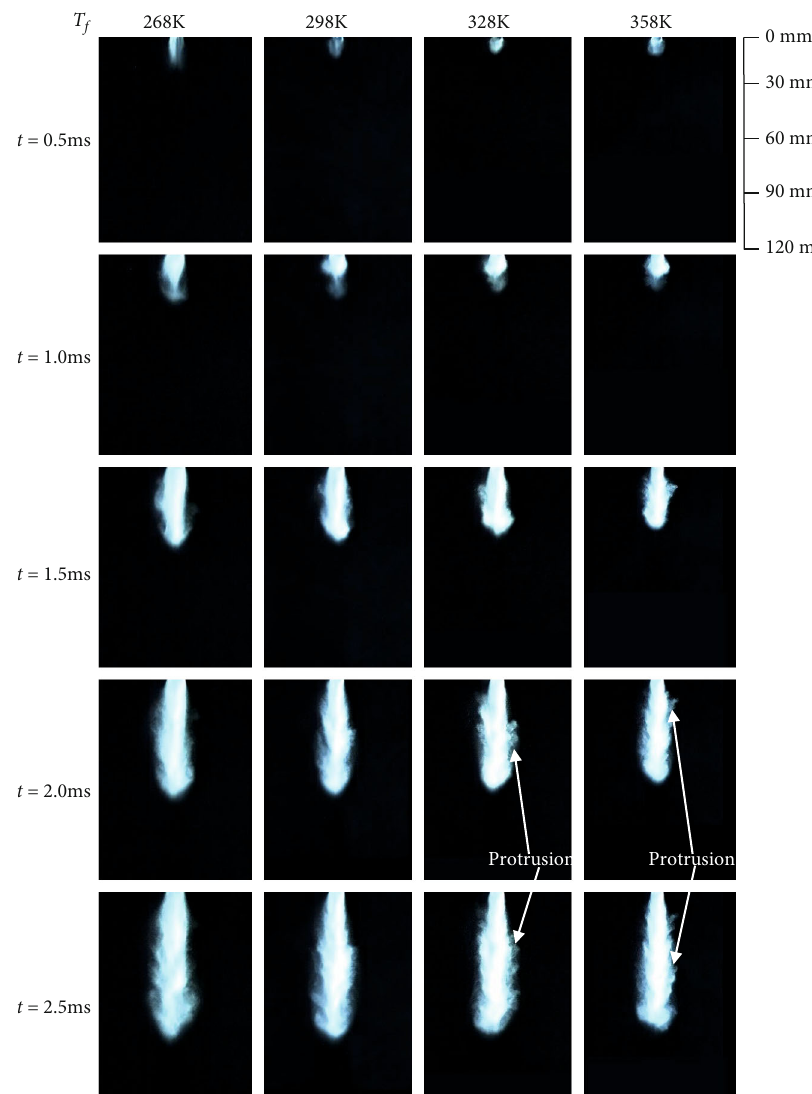
= 0 : 8MPa , Δ T = 4 : 0ms f f